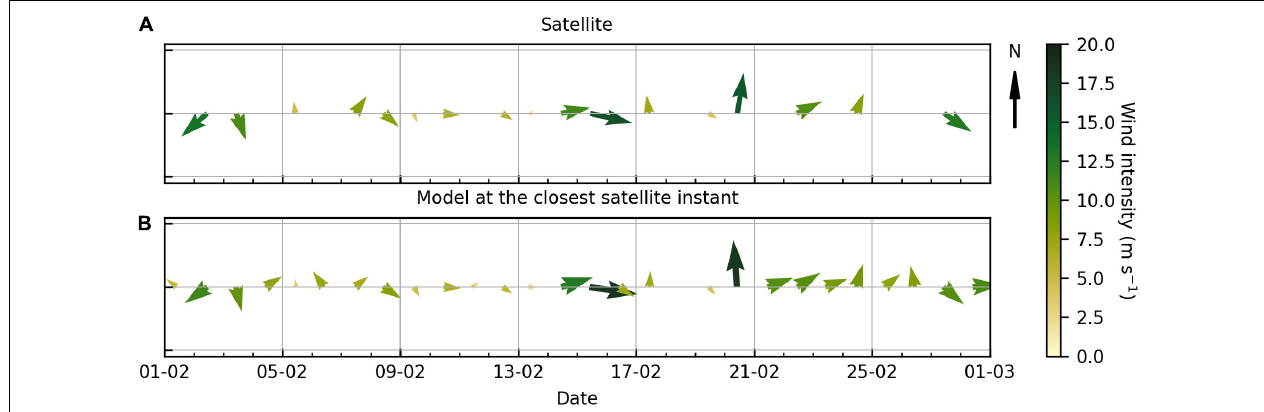
FIGURE 6 | Comparison of D3 domain spatial average of wind direction and intensity (m s − 1 ) from (A) ASCAT (descending satellite passage) and from (B) model simulations at the timestep closest to the time of the satellite